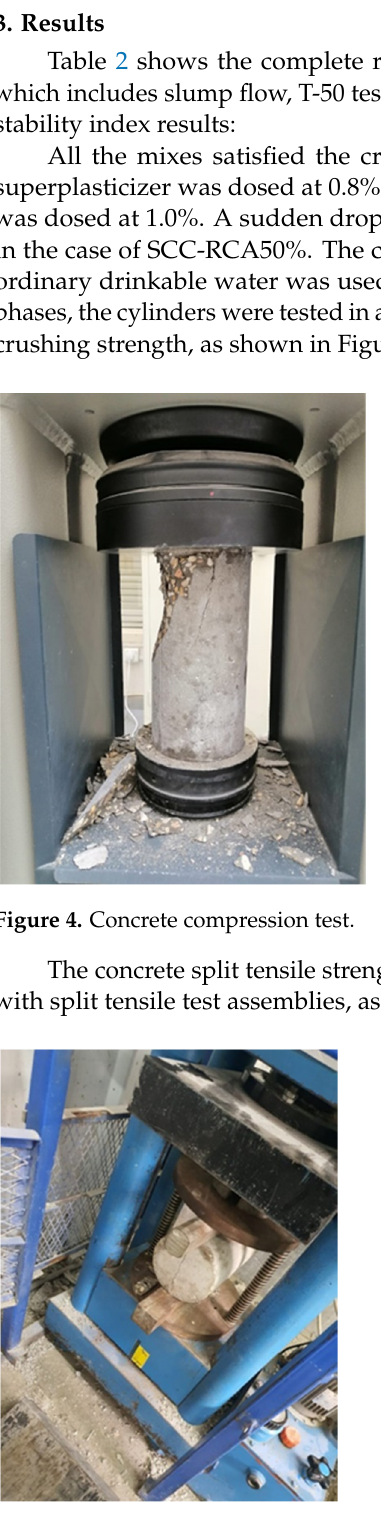
Table 3. Compressive strength and water absorption results.